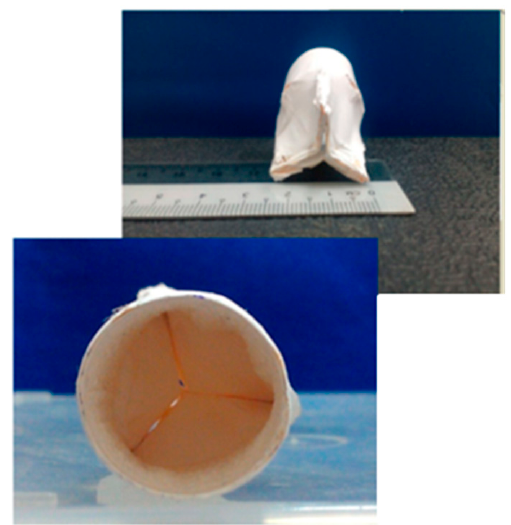
Figure 6. The 3D engineered aortic valve based on polyurethane/poly-L-lactic acid (TPU/PLLA) reported in reference [178]. In particular, 3.80% ( w / v ) MNPs were dissolved in TPU/PLLA mixture (50:50 v / v , 6.54 wt%); then, the mixture was subjected to electrospinning and collected into an aluminum foil based template of the valve obtaining the 3D scaffold reported.